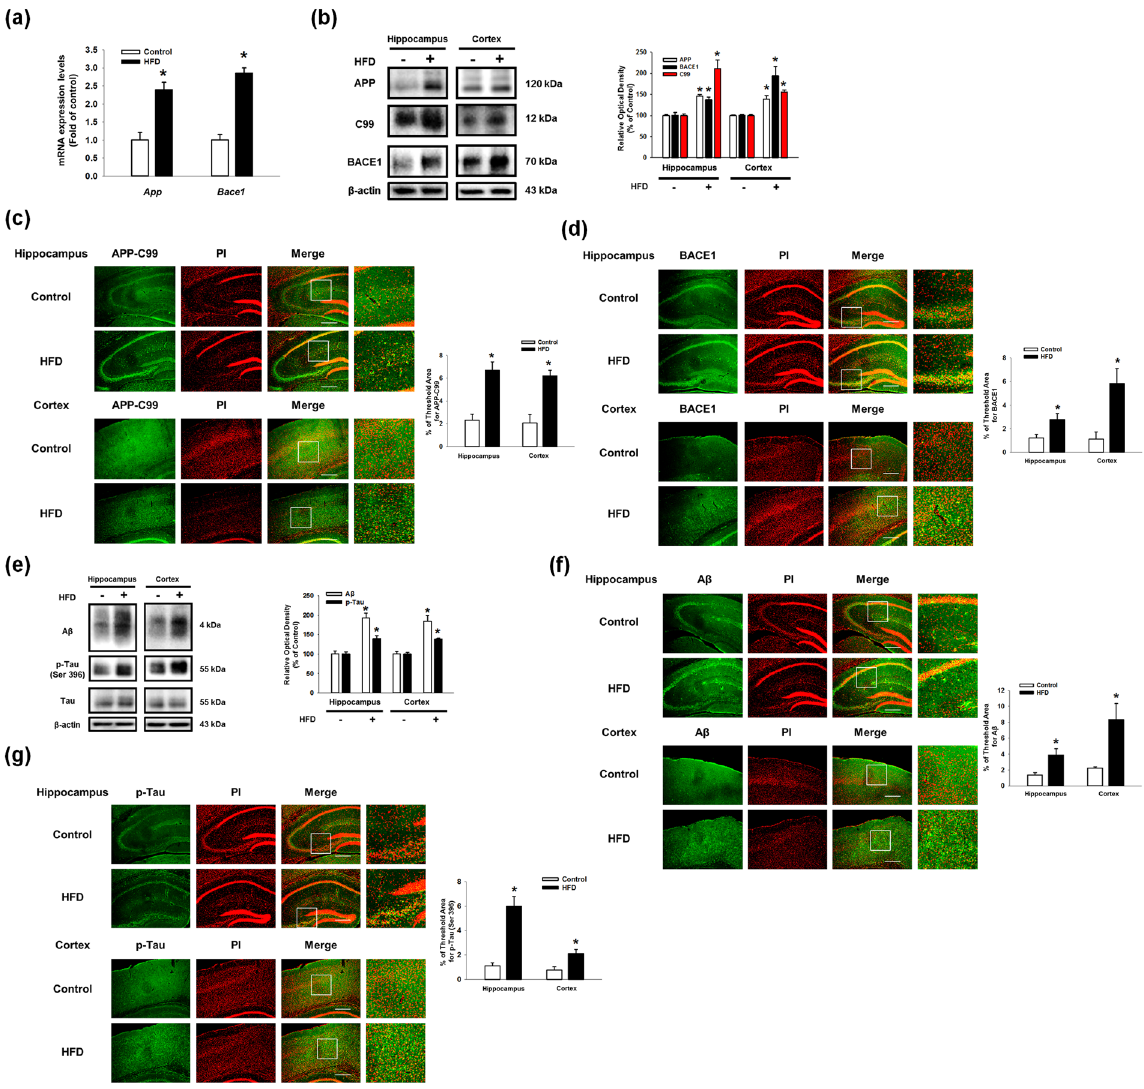
Figure 1. Effect of HFD on the regulation of A β regulating proteins expressions and A β production in the mouse brain. ( a ) Brains of 13 weeks old C57BL/6 mouse, which were fed with HFD for 8 weeks, were extracted. mRNA expressions of APP and BACE1 in brain samples were analyzed by quantitative real time PCR. Data were normalized by ACTB mRNA expression level. Data are reported as a mean ± S.E.M. n = 4 . ( b ) Extracted brains were cryo-sectioned coronally, and separated into hippocampus and cortex. The expressions of APP, C99, BACE1 and β -actin in hippocampus and cortex regions were analyzed by western blot. Data are reported as a mean ± S.E.M. n = 5 . ( c , d ) Brain samples for immunohistochemistry were immunostained with C99 and BACE1 antibodies and PI. Images shown in result are representative. All scale bars, 150 μ m (magnification, × 200). ( e ) A β , p-Tau (Ser396), Tau and β -actin protein expression levels in hippocampus and cortex regions of brain were assessed with western blot. ( f , g ) Brain samples for immunohistochemistry were immunostained with A β and p-Tau (Ser396) antibodies and PI. Image shown in result are representative. All scale bars, 150 μ m (magnification, × 200). Each blot result shown is representative image. Quantitative blot data are presented as a mean ± S.E.M. n = 5 . * p < 0.05 versus